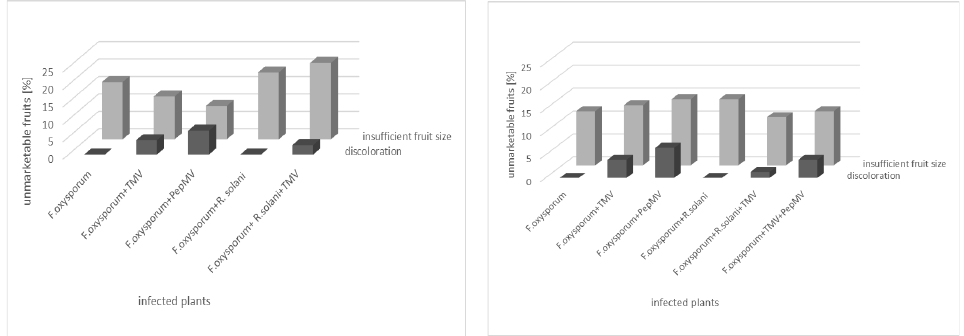
Figure 6. Influence of pathogens on the amount of unmarketable tomato fruits harvested from infected control plants (A1 to A8). During the cultivation period of 16 weeks, natural dispersal of the primarily single infected plants led to mixed infections. Tomato plants were grown in an NFT hydroponic system with recirculating fertigation solution. Harvest period was 10 weeks. Fruits with discoloration and diameter less than 40 mm or cracks were considered unmarketable. ( Left ): first survey, ( right ): second survey.